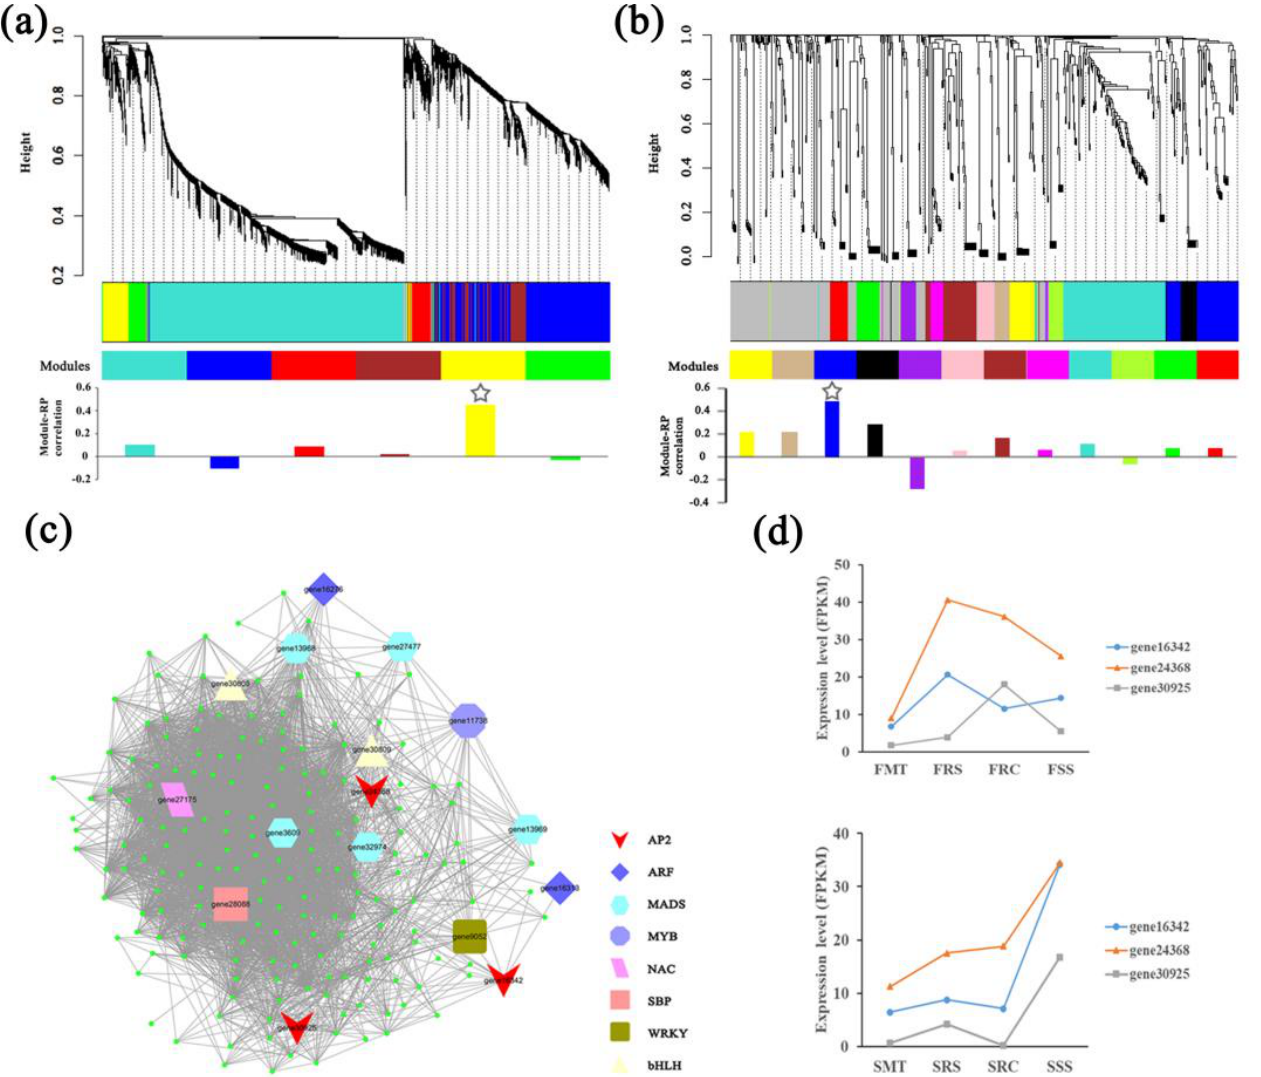
Figure 3. Weighted gene co-expression network analysis (WGCNA) and expression patterns of differ- entially expressed genes and miRNAs. ( a ) WGCNA was conducted on a total of 6659 differentially expressed genes ( p < 0.05) between the mature trees and at least one type of seedling over two years. Modules of co-expressed genes and their correlation with root-based vegetative propagation (RP) were assigned color bars beneath each dendrogram; ( b ) WGCNA was conducted on a total of 1169 differentially expressed miRNAs ( p < 0.05) between the mature trees and at least one type of seedling over two years. Modules of co-expressed miRNAs and their correlation with root-based veg- etative propagation (RP) were assigned color bars beneath each dendrogram; ( c ) The gene regulatory network of the Gyellow module. The large polygons indicate significantly differentially expressed TFs, while other genes are shown with small green circles; ( d ) Expression levels of three AP2-like TFs in one- and two-year-old seedlings and mature trees. Three biological replicates were sequenced for each sample group. The stars in ( a , b ) show the modules with the highest correlation coefficients. FMT, mature trees in the first year of sampling; FRS, one-year-old root sprouting seedlings; FRC, one-year-old root cutting seedlings; FSS, one-year-old seed-derived seedlings; SMT, mature trees in the second year of sampling; SRS, two-year-old root sprouting seedlings; SRC, two-year-old root cutting seedlings; and SSS, two-year-old seed-derived